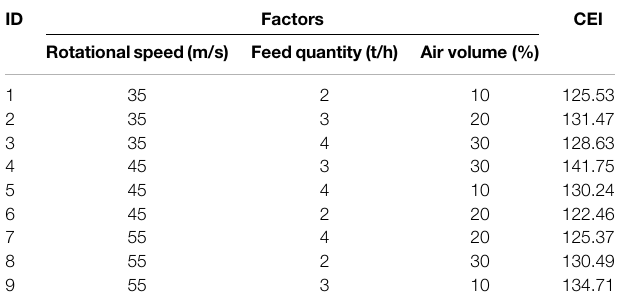
TABLE 8 | Parameter combination of aggregate processing equipment.